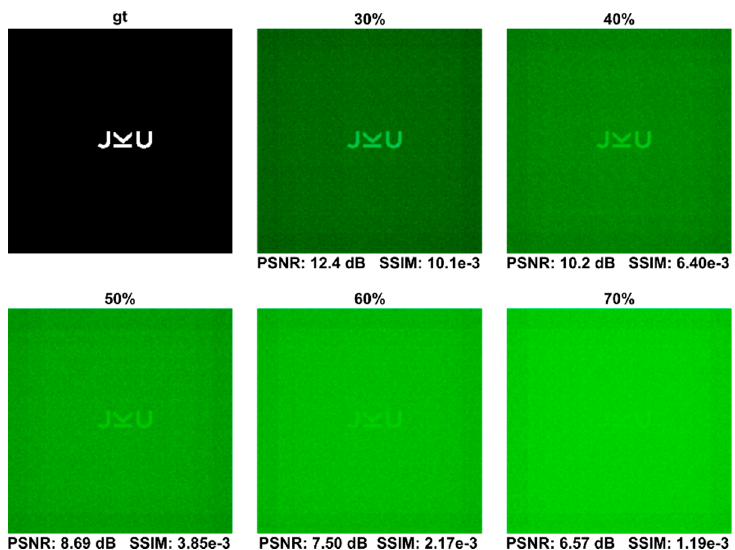
Figure A3. AOS simulation of increasing occlusion density above ground target at a 512 2 × 9 2 sampling resolution and a full synthetic aperture of 30 m diameter. Projected occlusion voxels are green. The numbers indicate the structural similarity index (Quaternion SSIM [36]) and the PSNR with respect to the ground truth (gt).